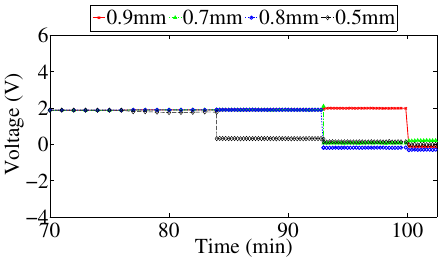
Figure 12. Peak amplitude of voltage across LEDs corresponding to their metal strips.